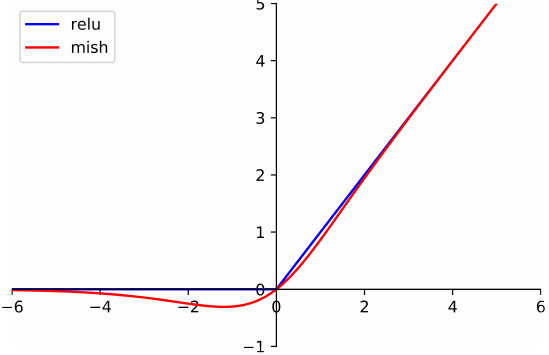
Figure 4. The difference between Mish and